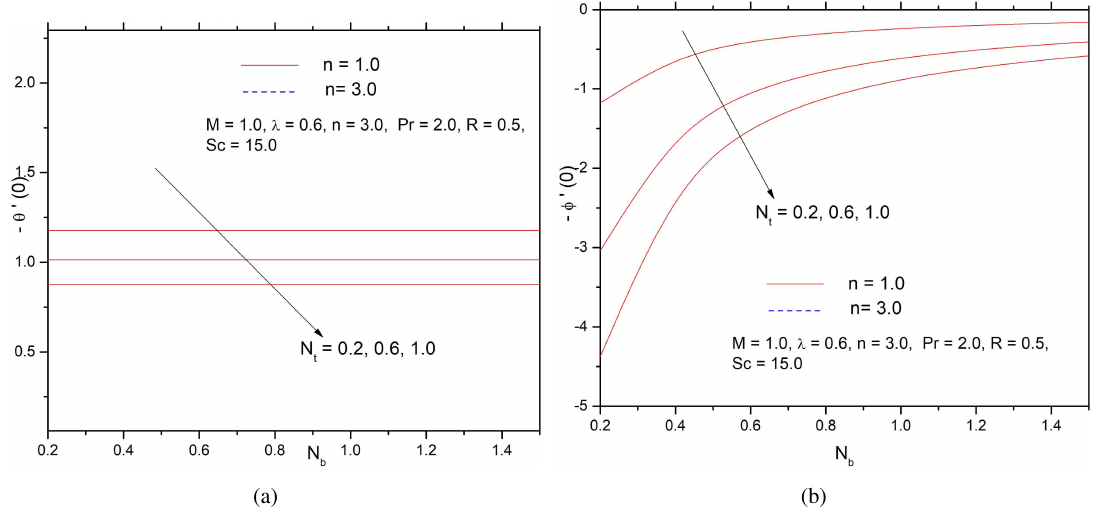
Fig. 12 Distributions of (a) − θ (cid:48) (0) for CWT (b) − ϕ (cid:48) (0) for ZMF with N b , Brownian motion parameter for diverse values of N t , thermophoresis